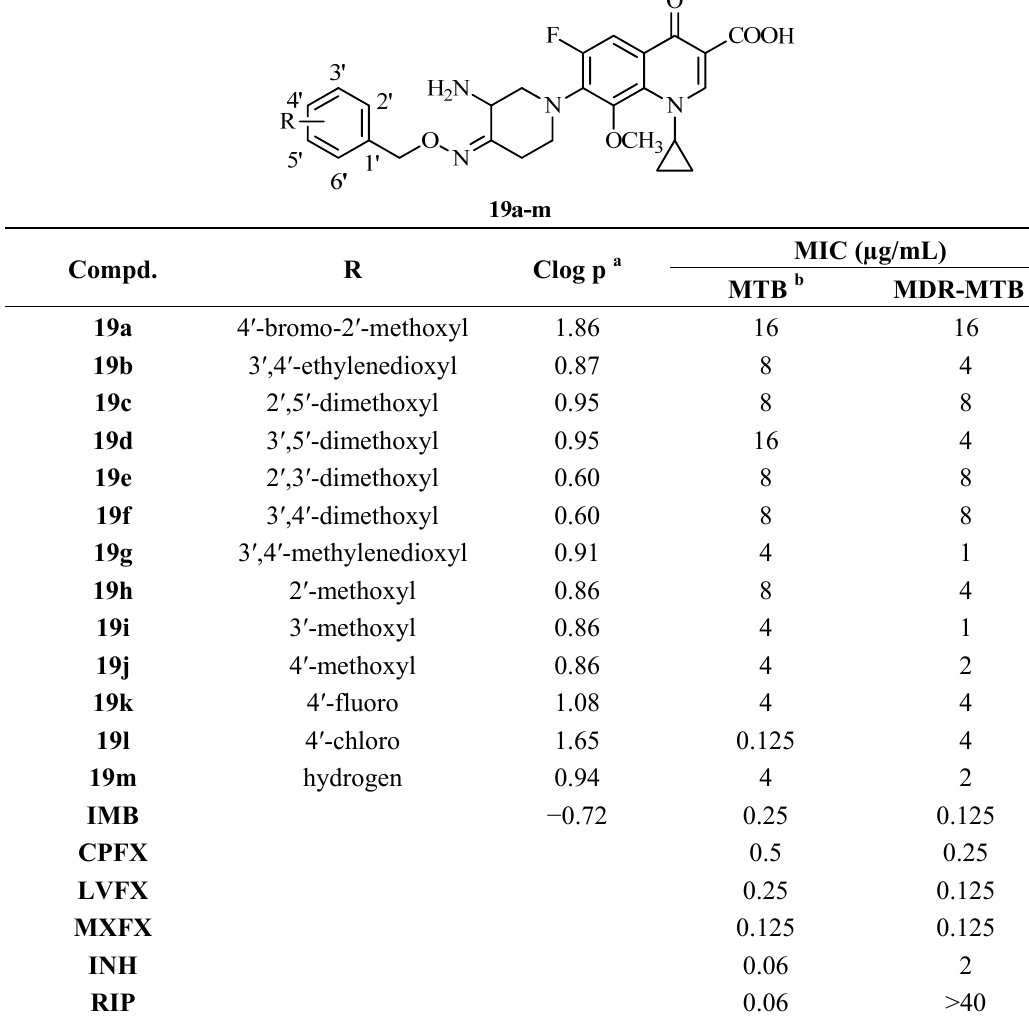
Table 1. Structures, lipophilicity and antimycobacterial activity of compounds 19a – m .